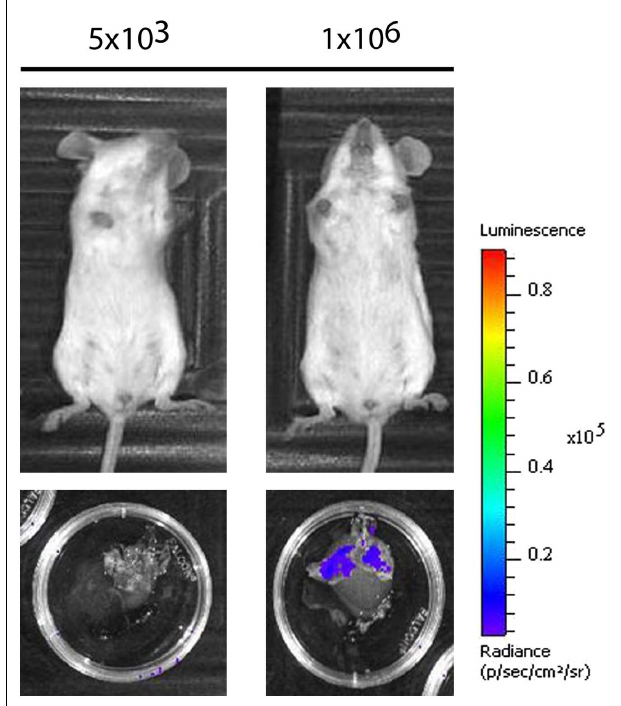
FIGURE 3 | In vivo imaging confirmation. CSM001 was i.n. inoculated at the indicated doses.The in vivo bioluminescence imaging was performed at 2h post-infection.The intensity of emission is represented as a pseudocolor image. Each animal was sacrificed and the lungs were harvested for ex vivo imaging. Images are representative of replicate